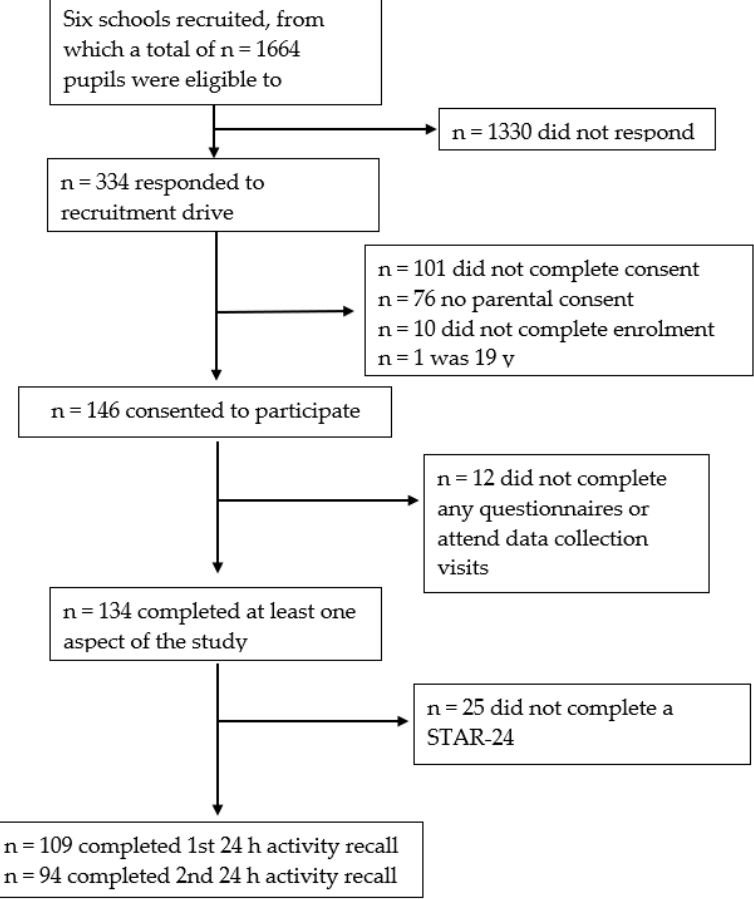
Figure 1. Participant flow